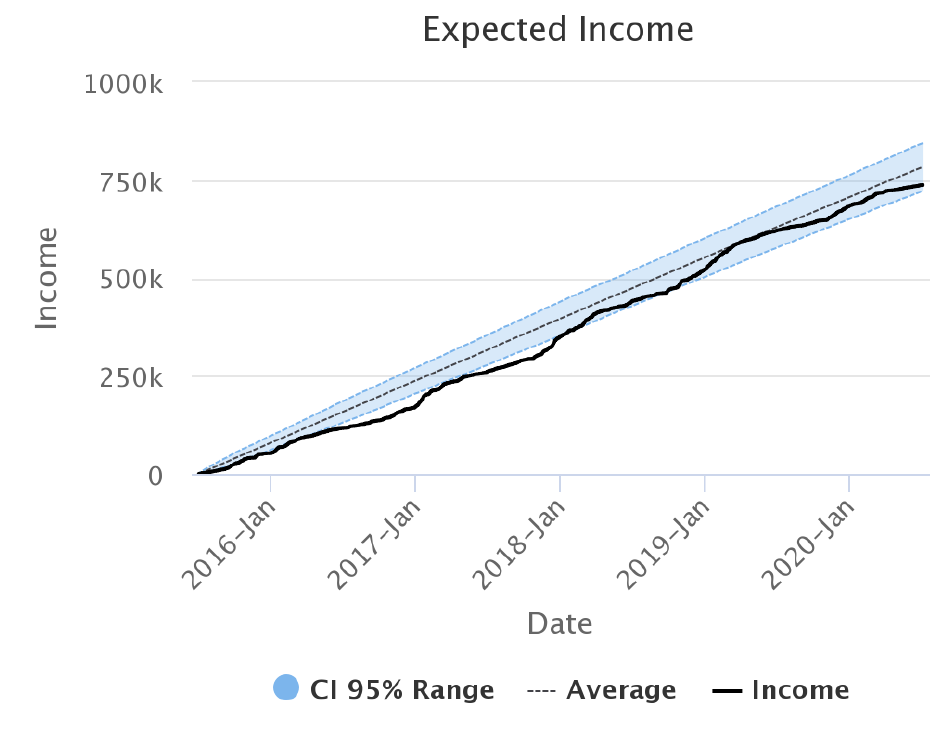
Figure 11. Energy–expected income with a 95% confidence interval